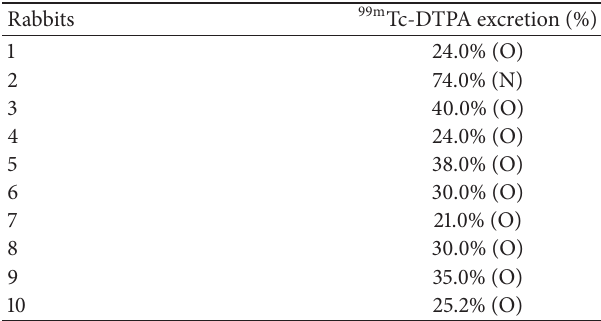
Table 1: Results of the scintigraphic study with 99m Tc-DTPA.